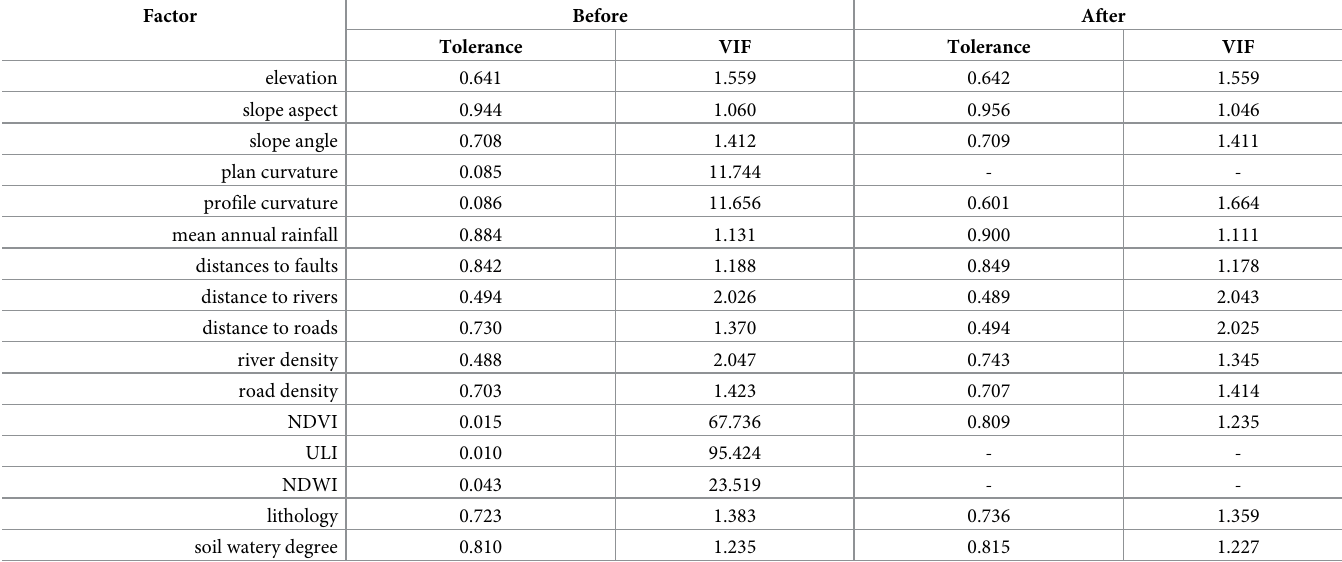
Table 2. The variance inflation factors and tolerances multicollinearity analyze of factors.